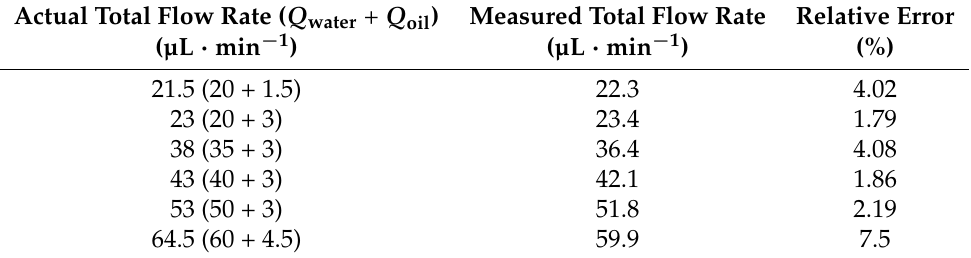
Table 2. Flow rates calculated by integrating the experimental velocity profile Equation